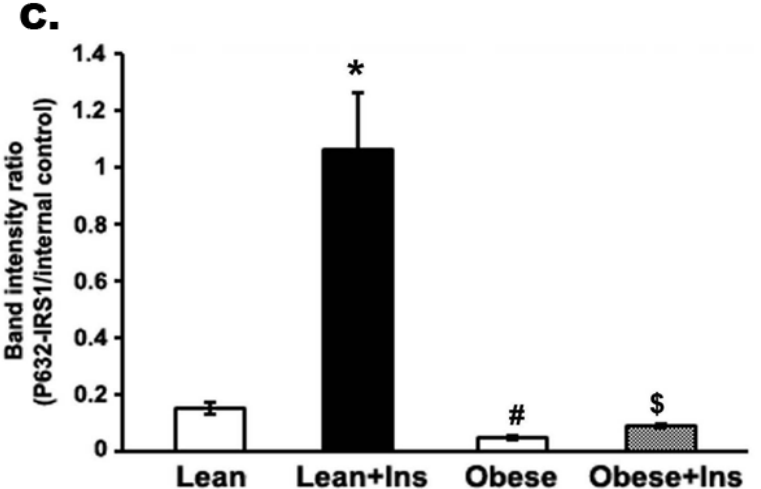
Figure 5. Serine-632 phosphorylation of IRS-1 in the gastrocnemius muscle of Zucker rats. Rats were anesthetized, and 5 units of insulin were intraperitoneally injected into both lean and obese rats. Then, 5 min later, gastrocnemius skeletal muscle was excised and homogenized in an extraction buffer at 4 ◦ C, as described in the Methods section. After centrifugation, aliquots with the same amount of protein were immunoprecipitated with anti-IRS1 antibodies at 4 ◦ C and, subsequently, protein A-sepharose. Immunoprecipitated proteins were immunoblotted with anti-serine-632-IRS-1 antibody, and bands were quantitated with a Bio-Rad Molecular Imager. ( A ). Representative immunoblot of serine-632-IRS-1 phosphorylation in lean rats and OZRs. ( B ). Immunoblot of serine-632-IRS-1 in lean rats and OZRs with and without insulin stimulation. ( C ). Bar graph showing band intensity ratios of serine-632-IRS1 phosphorylation in terms of internal control (IgG ab). * p < 0.01; # p < 0.05 vs. corresponding lean value; $ p <0.01 vs. lean + insulin. In each group, five rats were employed.